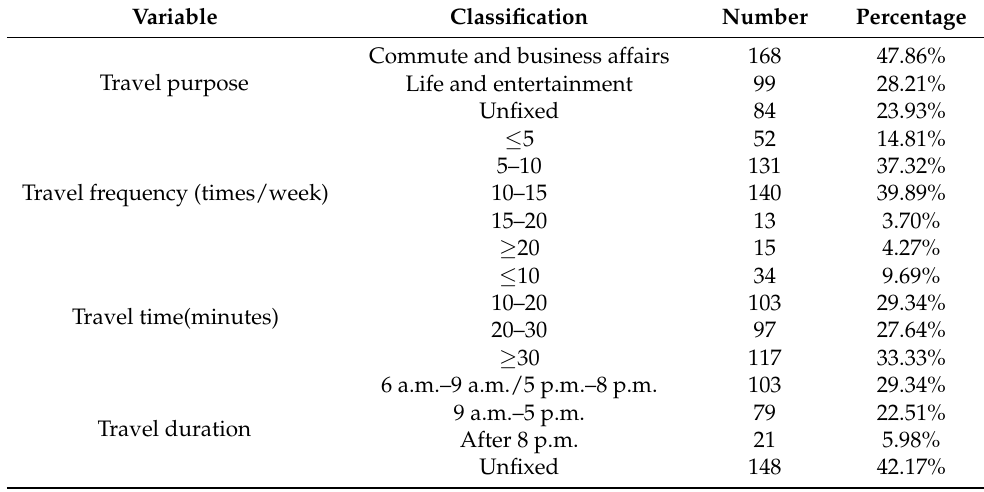
Table 3. Travelling mode of